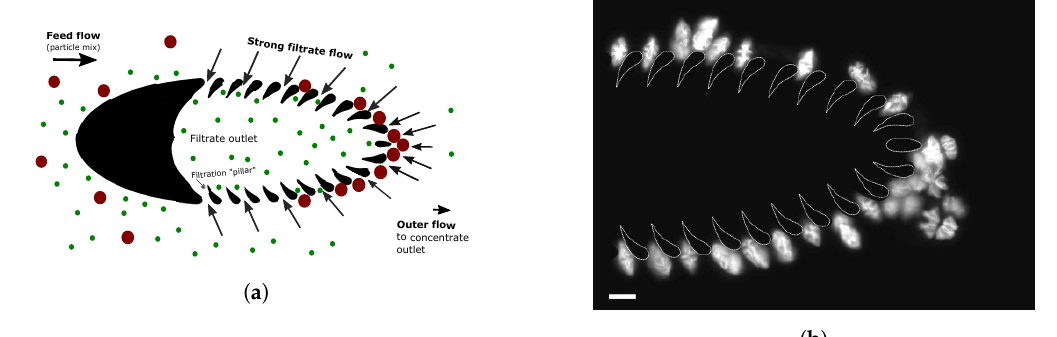
Figure 4. ( a ) In the absence of flow control, the filter displays dead-end filtration behavior, which is associated with clogging issue. ( b ) Clogging of a disk-shaped algal cell (37 by 77 µ m) as a result of dead-end filtering. Scale bar: 50 µ